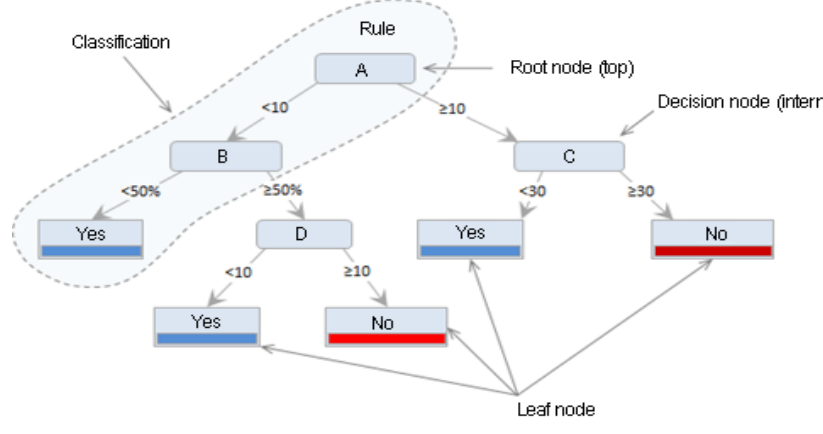
Figure 3. Example of a decision tree structure.